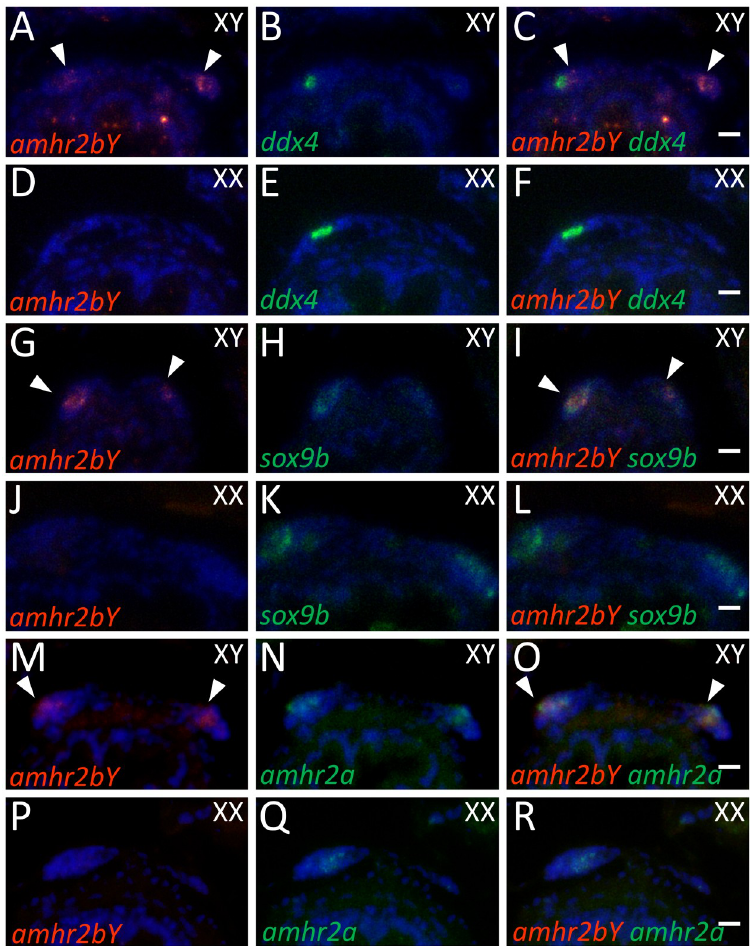
Fig 6. Expression of amhr2bY in morphologically undifferentiated gonads in ayu. (A–F) Two-color section in situ hybridization showing amhr2bY (A and D, red) and germ cell marker ddx4 (B and E, green) in XY (A–C) and XX (D– F) gonads at 2 months post fertilization (mpf). (G–L) Two-color section in situ hybridization showing amhr2bY (G and J, red) and sox9b (H and K, green) in sexually undifferentiated somatic cells in XY (G–I) and XX (J–L) gonads at 2 mpf. (M-R) Two-color section in situ hybridization showing amhr2bY (M and P, red) and autosomal amhr2a (N and Q, green) in XY (M–O) and XX (P–R) gonads at 2 mpf. amhr2bY mRNA specifically accumulated in somatic cells surrounding germ cells in morphologically undifferentiated gonads of genetic males. Autosomal amhr2a mRNA was expressed in somatic cells in morphologically undifferentiated gonads of both genetic males and females. Transcripts of amhr2bY and amhr2a co-localized in somatic cells. Arrowheads indicate amhr2Y -positive signals. Scale bar: 10 μ m.